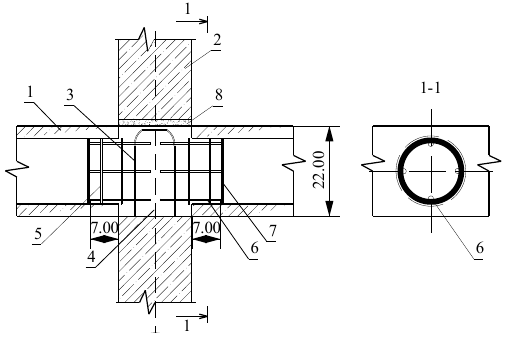
Fig. 3. Connections of reinforced concrete slabs with a girder in precast-cast-in-place floor slabs with dual functional purpose of Fig. 4. Contact-platform joint of panel walls with hollow-plate the principal reinforcement support zones brought beyond the wall area: 1 – hollow-core slab; 2 – wall panel; 3 – stub bars from the wall panel; 4 – grouting concrete; 5 – key; 6 – key reinforcement cage; 7 – key size limiter; 8 – cement-sand mortar The keys are made by sampling the concrete in the right places during the slab molding process. Multi-keyed joint with rectangular concrete and reinforced concrete keys, preferably with l k /h k = 0.25 is considered. The proposed by authors meth- odology for joints calculating [4] takes into account the nature of their destruction and the main determining factors: strength characteristics of concrete f cd and f ctd , the ratio of the depth l k and the height h k of the keys, the shape of their cross section, the shape of the profile, reinforcement, the number of keys ( Fig. 5 ).